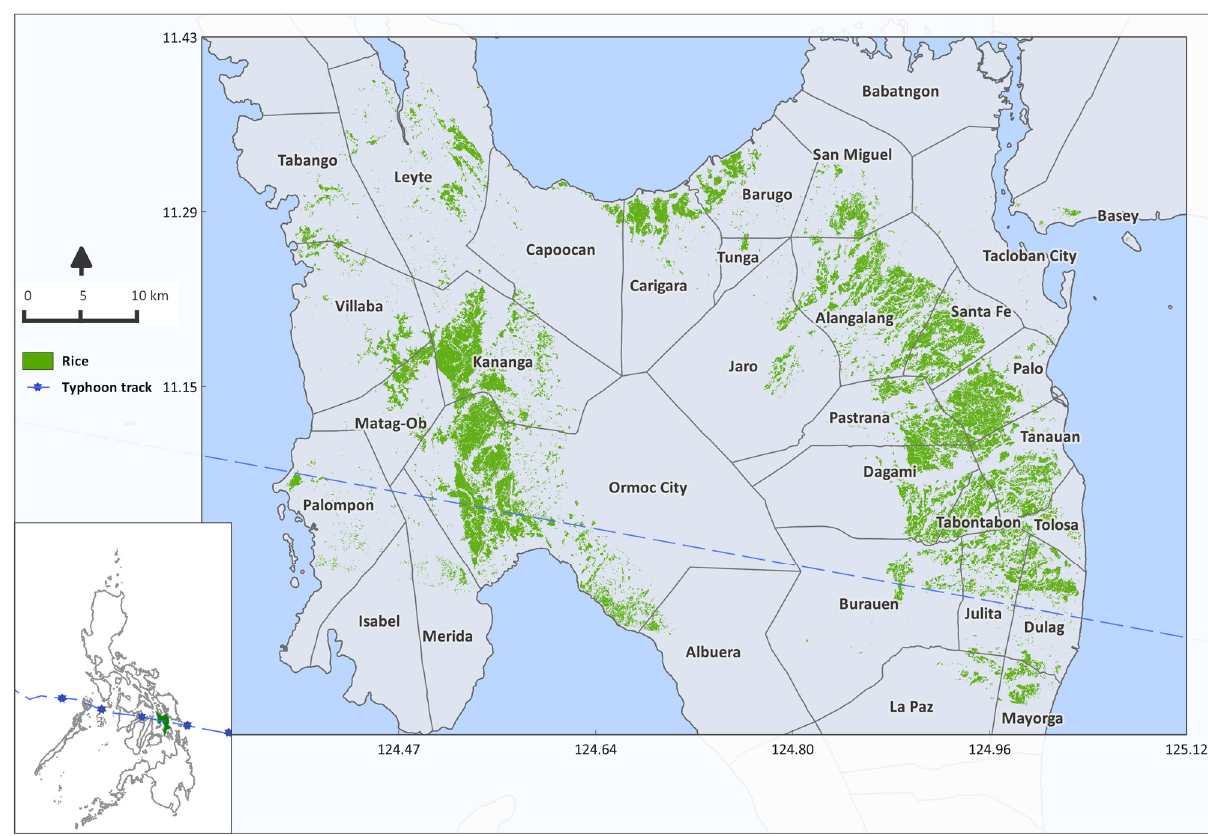
Figure 4. Northeastern part of Leyte Province. Wet season rice area in green, track of typhoon Haiyan in blue, municipal boundaries in black. Inset map shows the location of Leyte in the